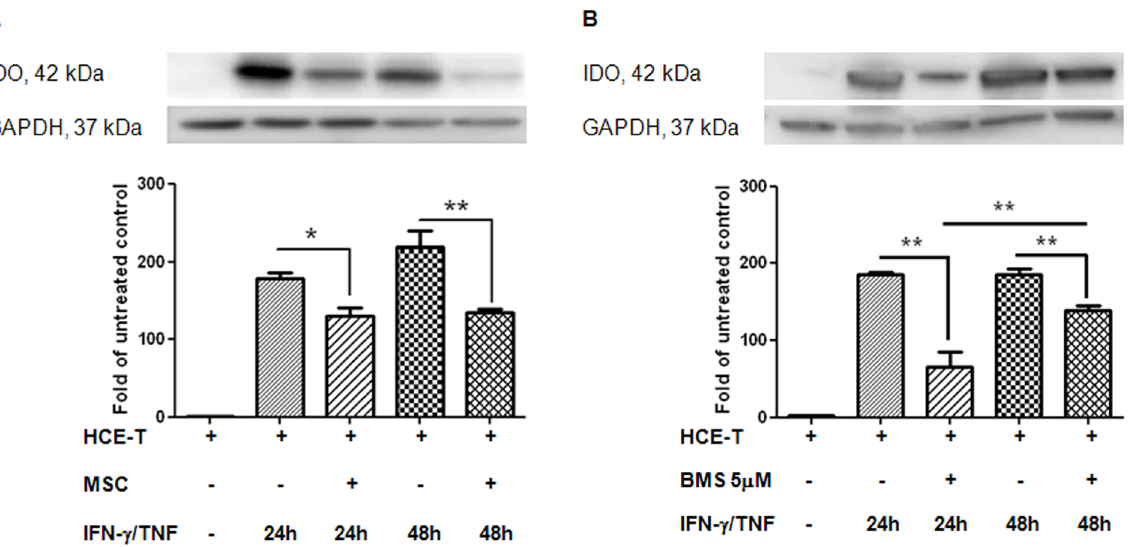
Figure 4. The modulatory effect of MSC on cytokine-induced IDO expression, and the association of NF- k B to the modulation. The upper panels are representative images of individual experiments. ( A ) Bar graphs show IDO expression in untreated HCE-T, HCE-T monocultures and HCE-T/MSC co-cultures stimulated for 24 h and 48 h with IFN- c (100 U/ml) and TNF (100 U/ml), semi-quantified by densitometry with GAPDH as loading control. Combination treatment with cytokine remarkable induced IDO expression in HCE-T monocultures, while HCE-T/MSC co-cultured significantly attenuated this induction on 24 h (p , 0.05) and 48 h (p , 0.01). ( B ) Treatment with BMS-345541, a NF- k B pathway inhibitor, significantly reduced the cytokine-induced-IDO expression at both 24 h and 48 h (p , 0.01). Data represents the results from three individual experiments (n=3) 6